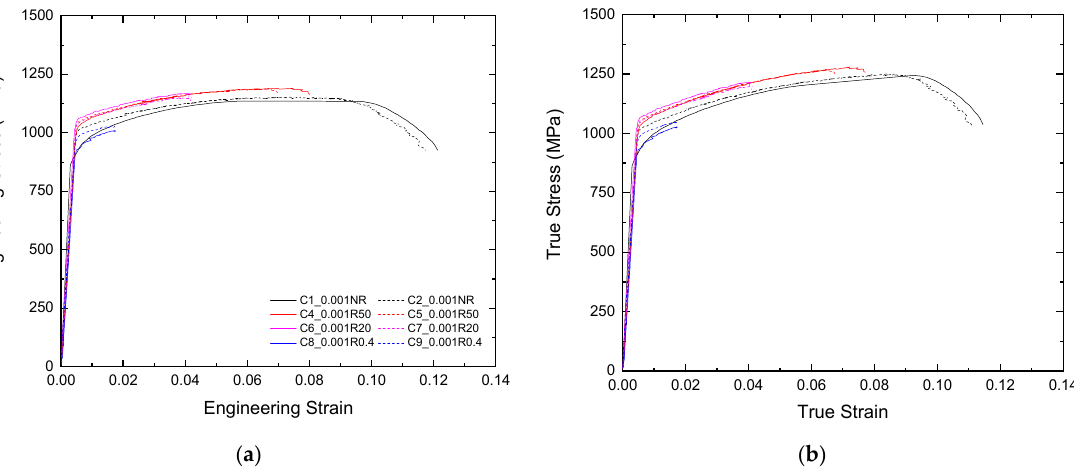
Figure 7. Engineering stress–strain ( a ) and true stress strain ( b ) curves for uniaxial tests with different notch sizes.